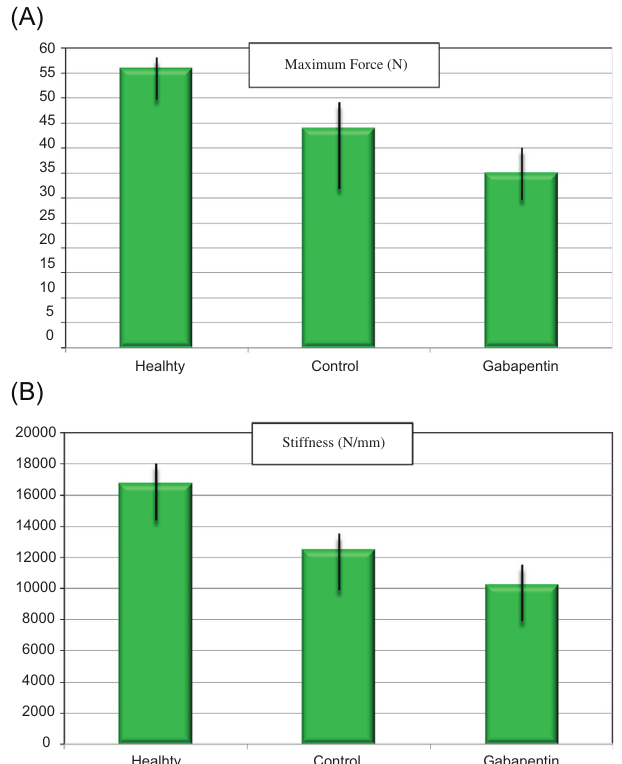
Figure 3. (A and B): The maximum force and stiffness values of the intact femora and fractured femora from control and gabapentin treatment groups on the 30th